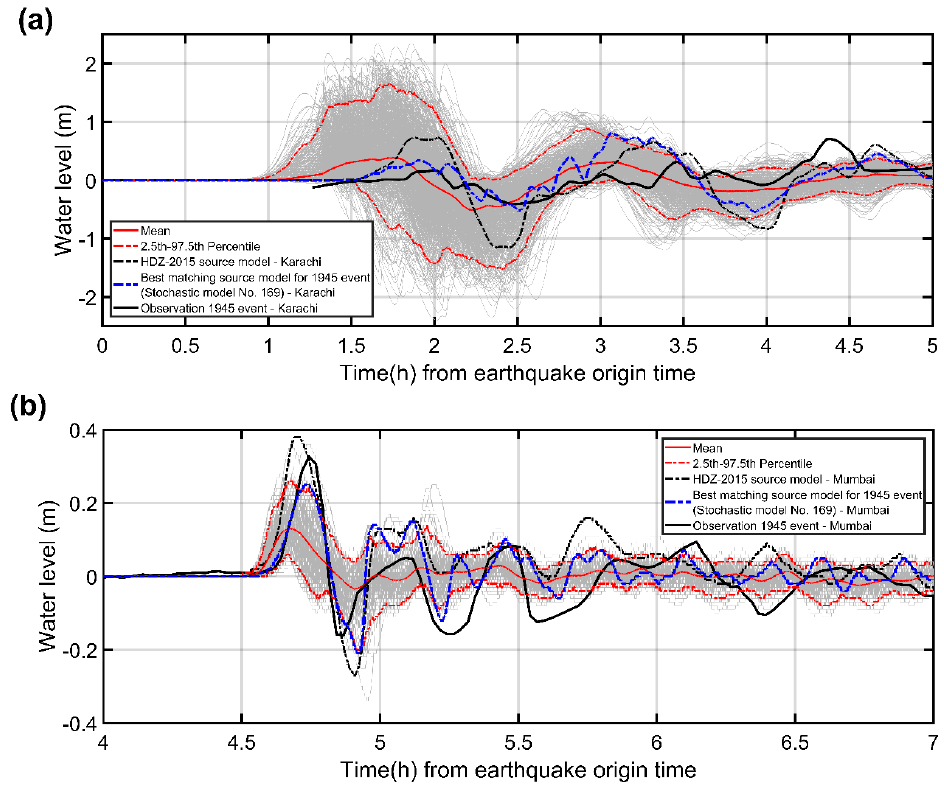
Figure 8. Comparison of time histories of tsunami wave for the 1000 stochastic models (mean, 97.5th percentile, and 2.5th percentile) and the HDZ-2015 model with the observations at the Karachi ( a ) and Mumbai ( b ) stations.